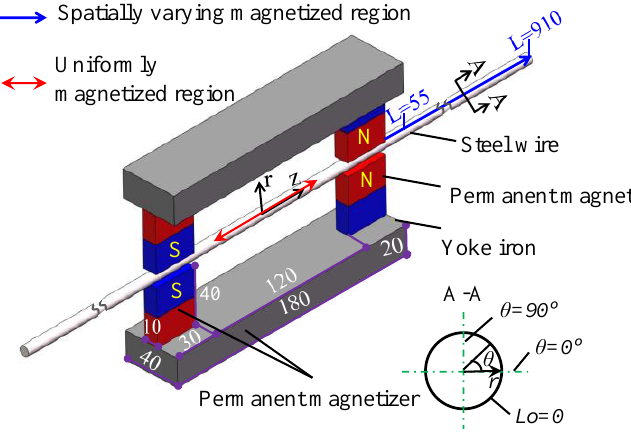
Figure 2. The dimensions of static magnetization unit for evaluating the stress in steel wires (Unit: mm).